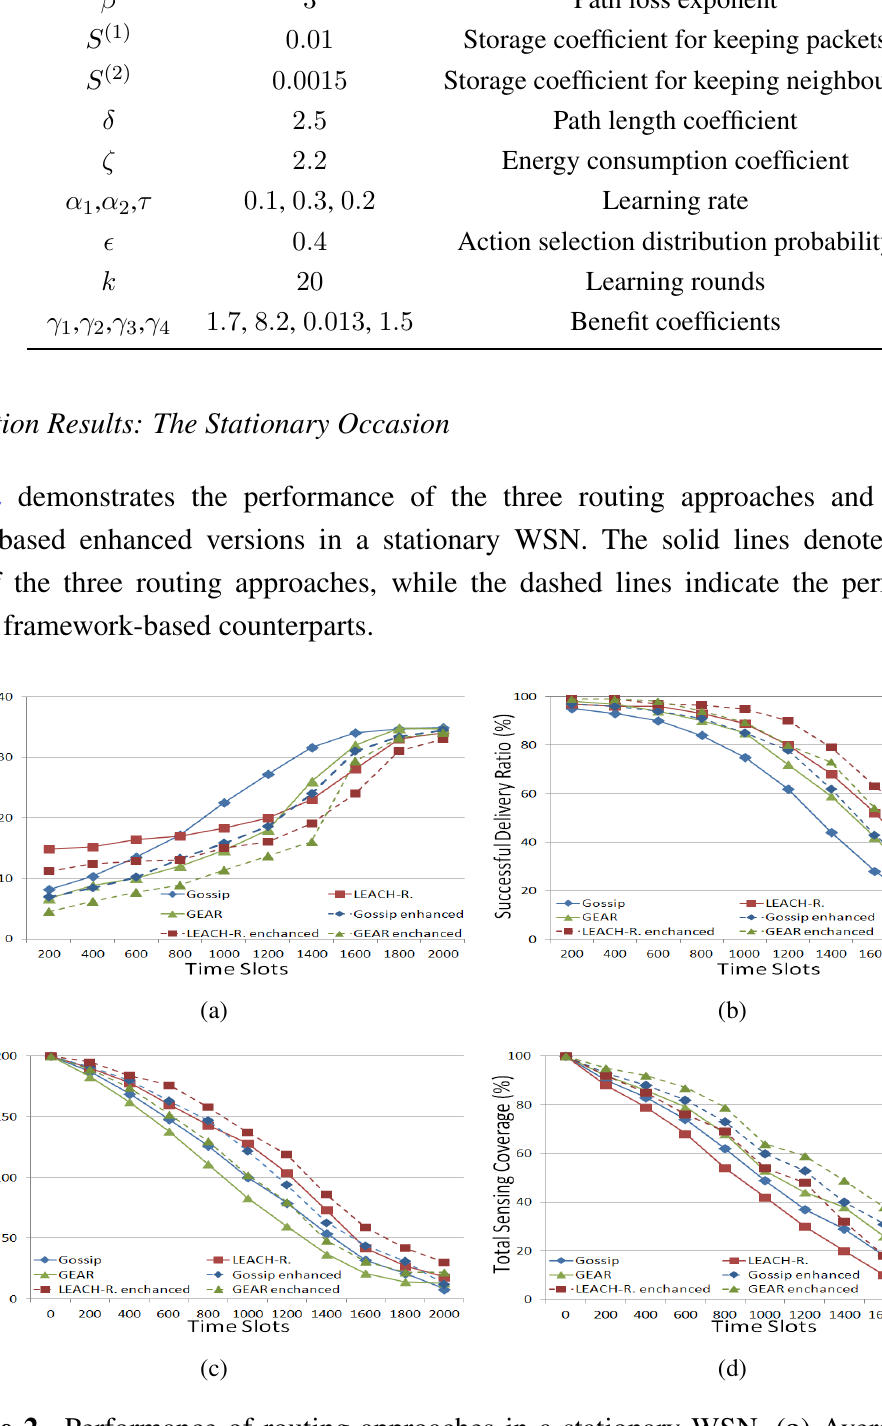
Figure 2. Performance of routing approaches in a stationary WSN. ( a ) Average delivery latency; ( b ) successful delivery ration (%); ( c ) number of live nodes; ( d ) total sensing coverage